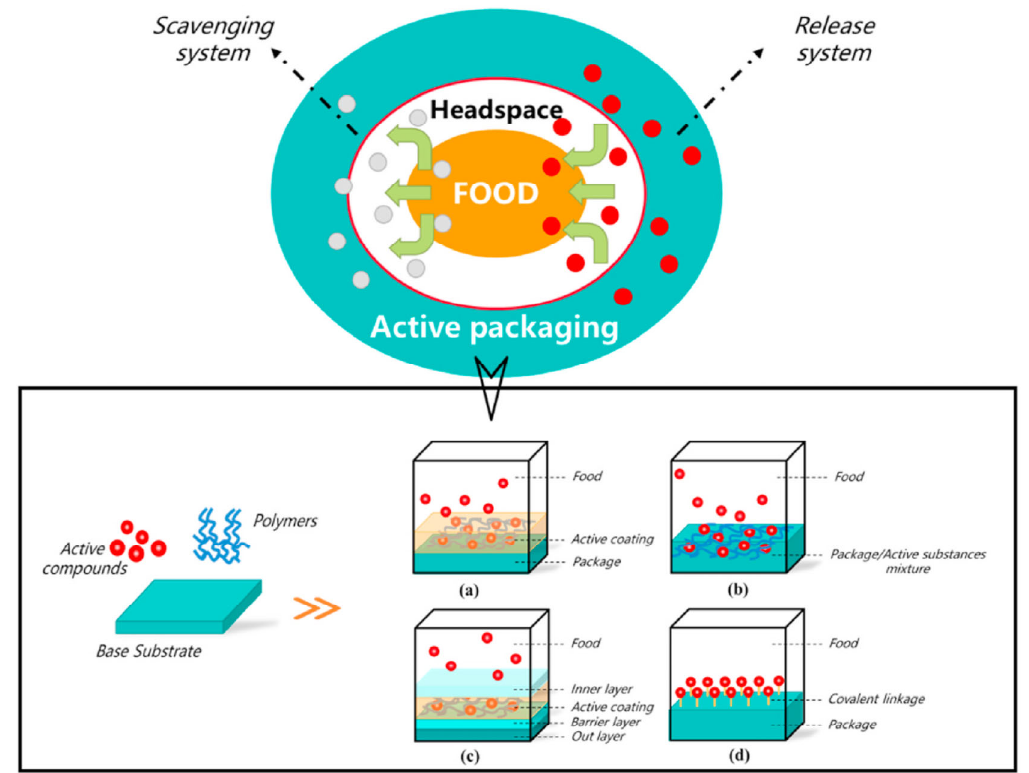
Figure 2. Main active antioxidant packaging systems (a) A releasing system in which active com- pounds are coated onto the surface of the packaging film (b) A releasing system in which active compounds are incorporated into the packaging film using polymers (c) A releasing system in which active compounds are incorporated into a different layer of the packaging films for more precise and controlled release (d) An oxygen scavenging system in which active compounds are covalently bound onto the surface of the packaging films(reprinted with permission from [63]).